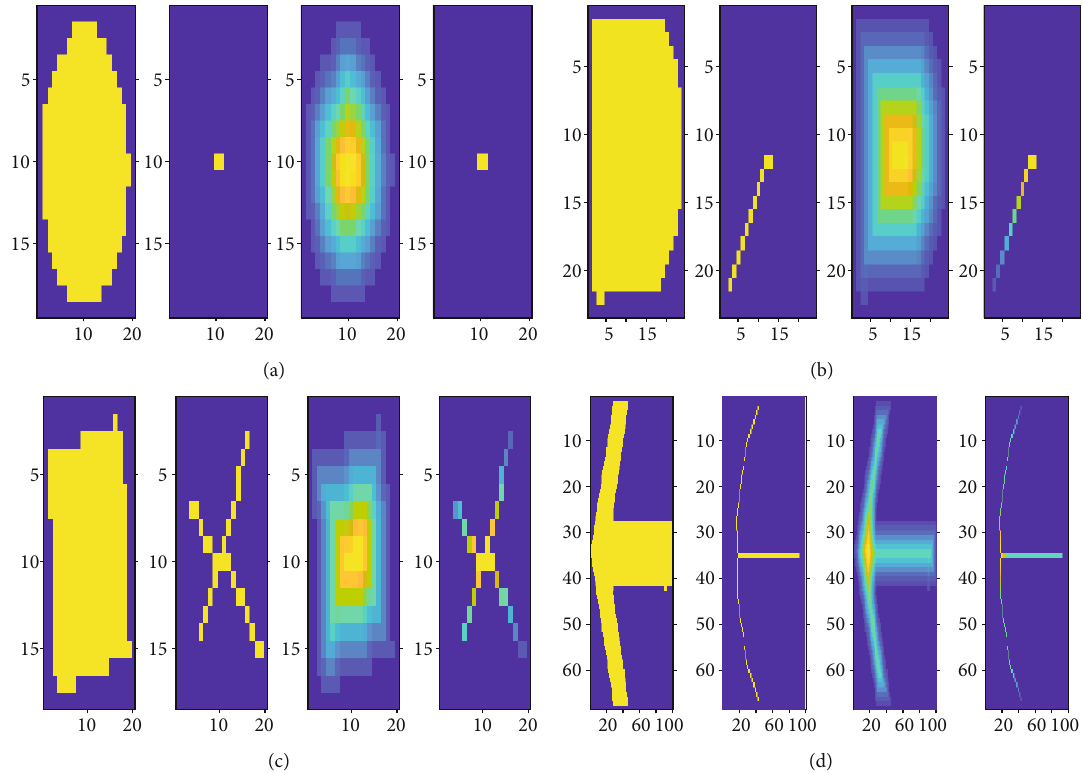
Figure 9: Identi fi cation pro fi le of a conventional MSER and a fusion